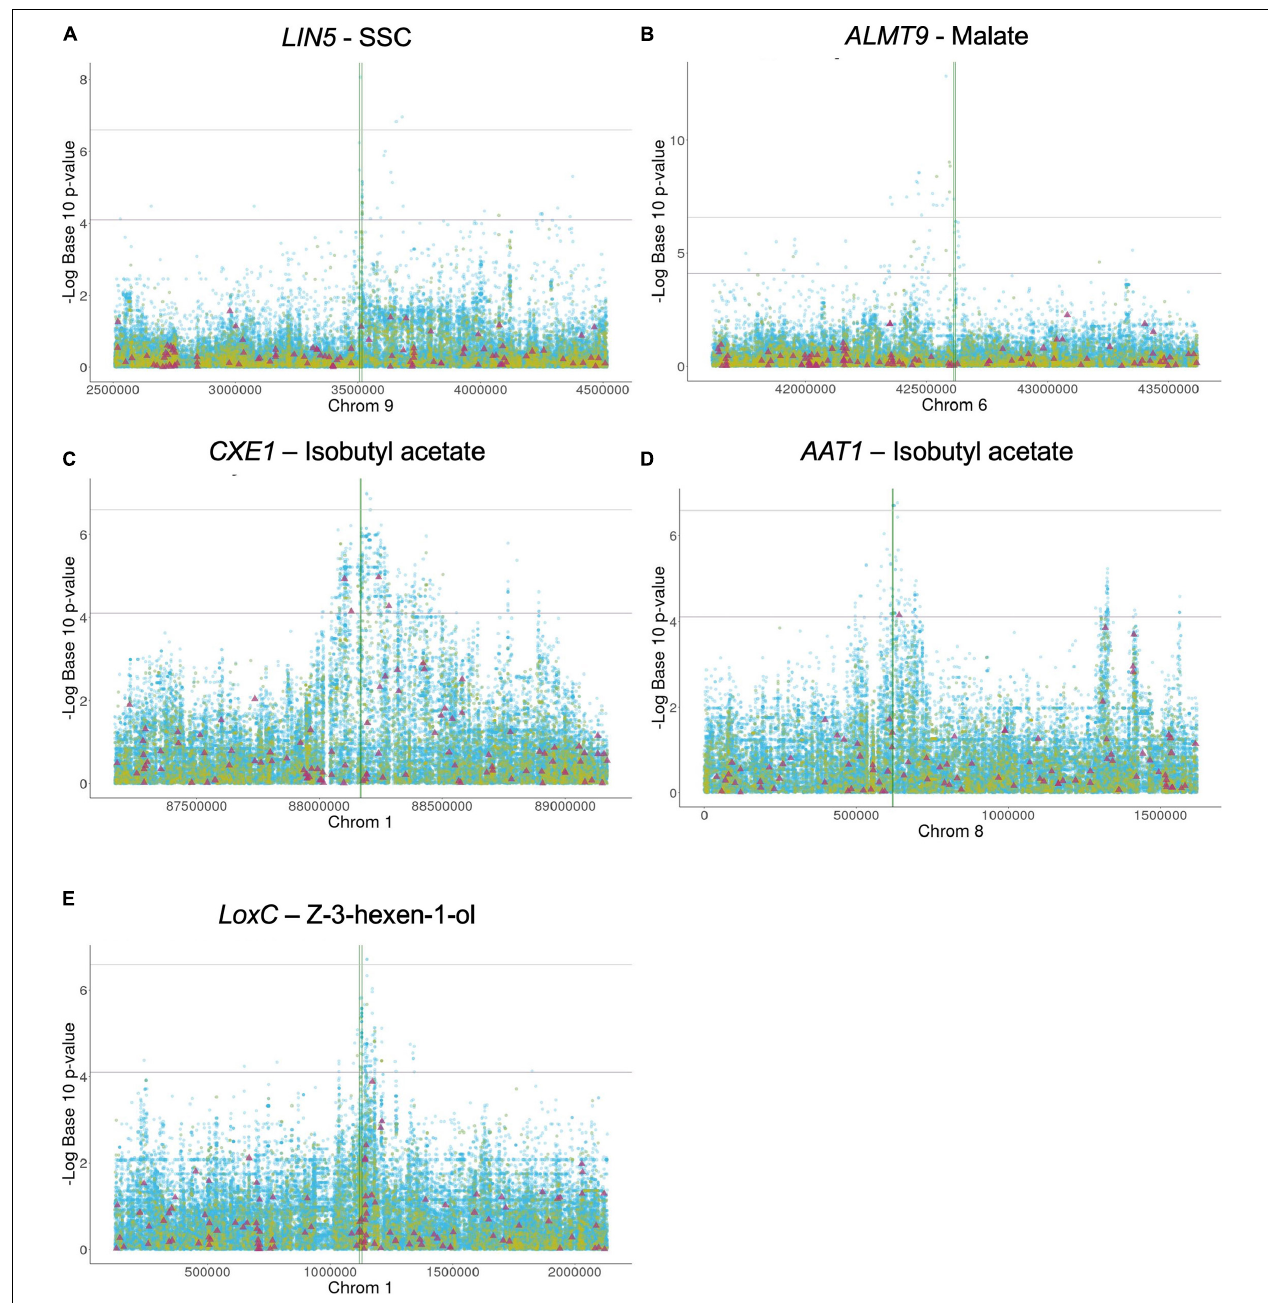
FIGURE 1 | (A-E) Local association mapping for flavor genes and their corresponding metabolites. SNPs are plotted as blue dots, INDELs as yellow dots and SVs as purple triangles. Horizontal lines represent 0.05 and 0.01 significance thresholds. Vertical lines mark the genic region.